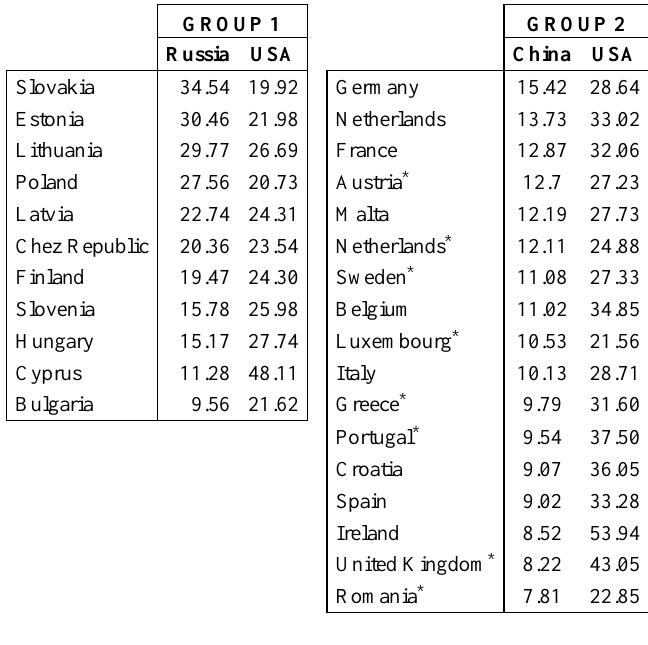
Table 2: Countries by Importance of Destination